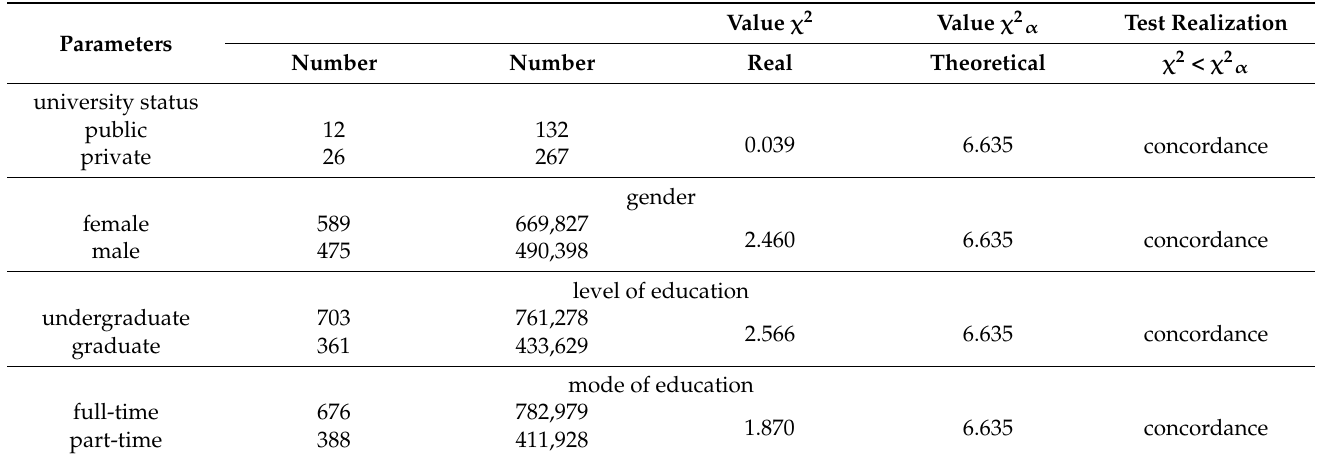
Table 1. Sample representativeness–Statistical concordance test χ 2